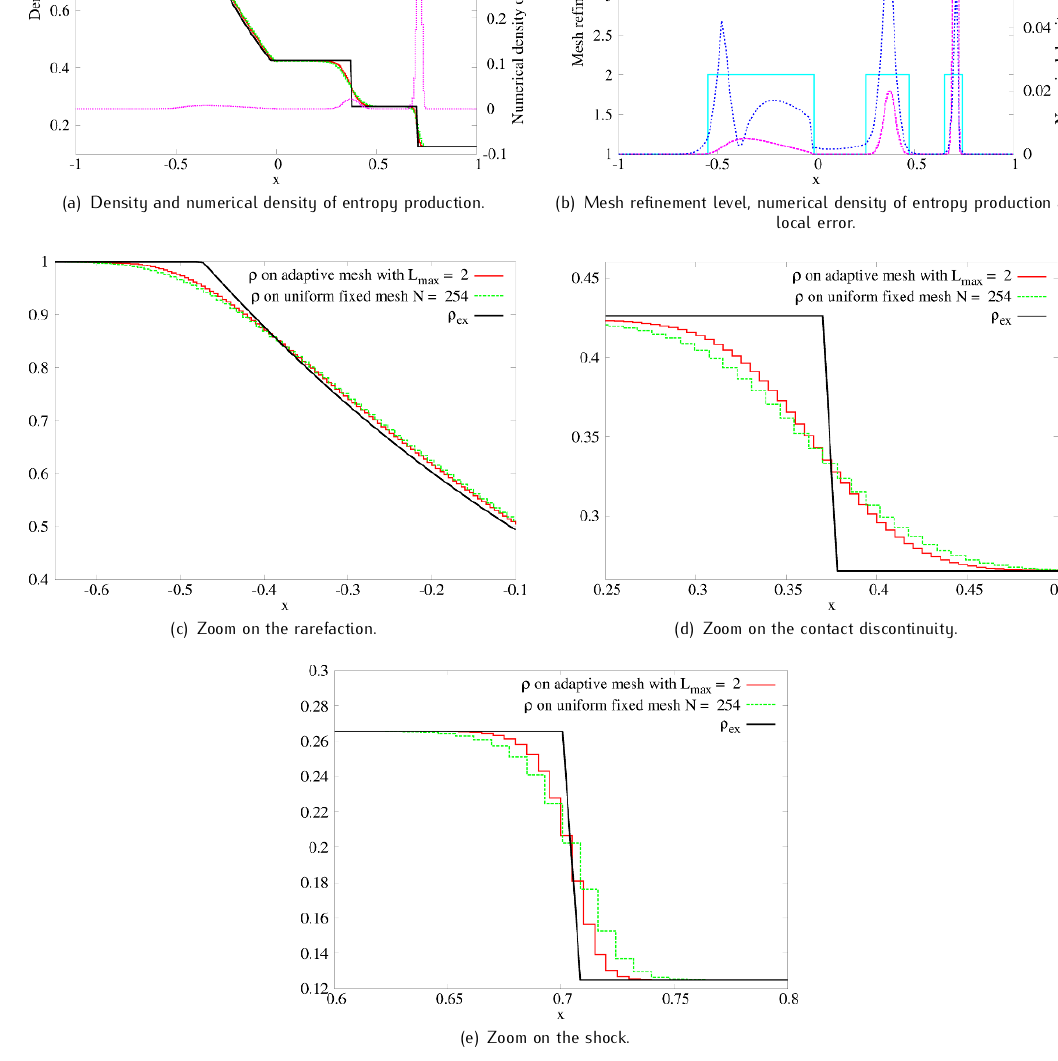
Figure 6. Sod’s shock tube problem: solution at time t = 0 . 4 using the AB1M scheme on the dynamic grid with L the fixed uniform grid of 254 cells.